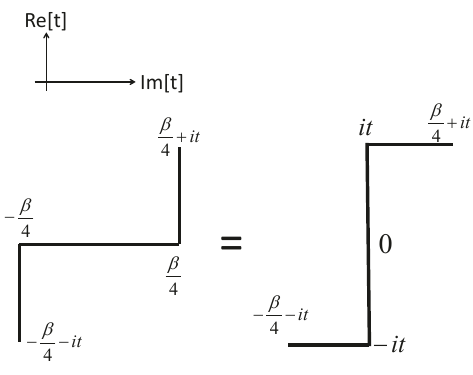
Figure 8 . The choices of path-integral contour for the TFD states. We employ the time coordinate in the (cid:12)rst CFT H 1 . The left and right choices are equivalent.